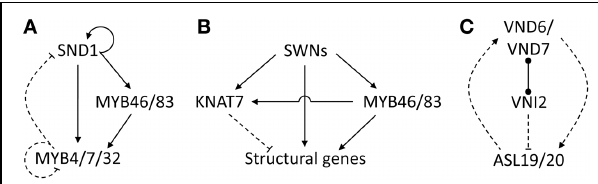
FIGURE 3 | Putative modules and motifs underlying SCW transcriptional regulation. (A) Negative feedback loop regulating SND1. (B) Negative regulation of structural genes by KNAT7. (C) Positive feedback loop regulating VND6/VND7. Dashed edges indicate unknown molecular mechanisms of protein–DNA interactions. Arrows indicate positive regulation, blunt ends indicate negative interactions. Dumbbells represent protein–protein interactions. Refer to (see section Network Dynamics) for detailed